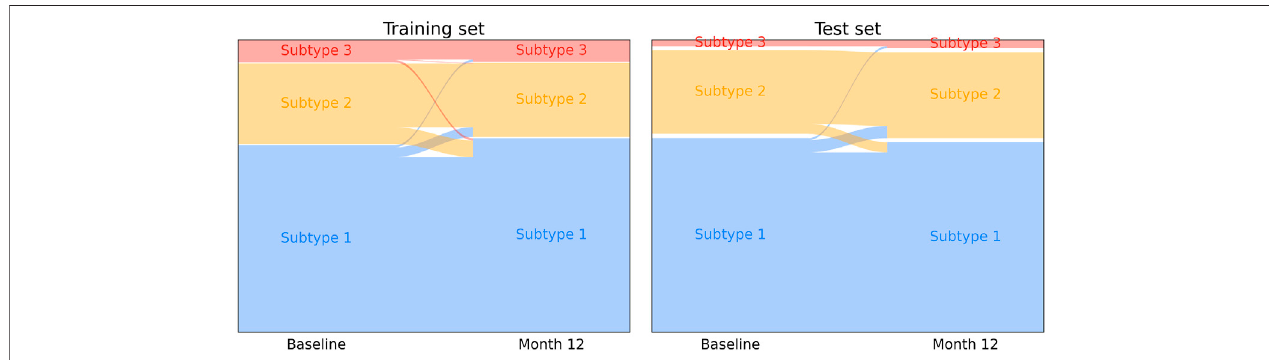
FIGURE 4 | Longitudinal subtype consistency for training set subjects (left) and test set subjects (right) over a 12-months follow-up period.